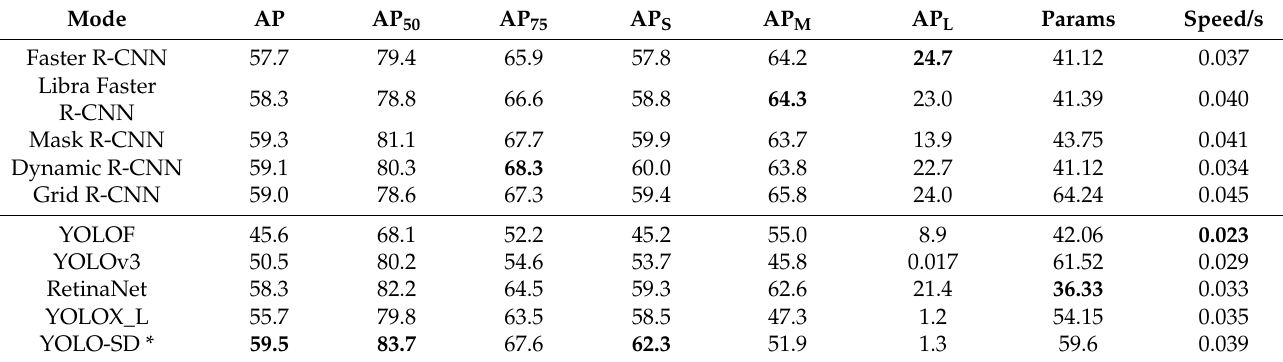
Table 4. Results of various models on HRSID.